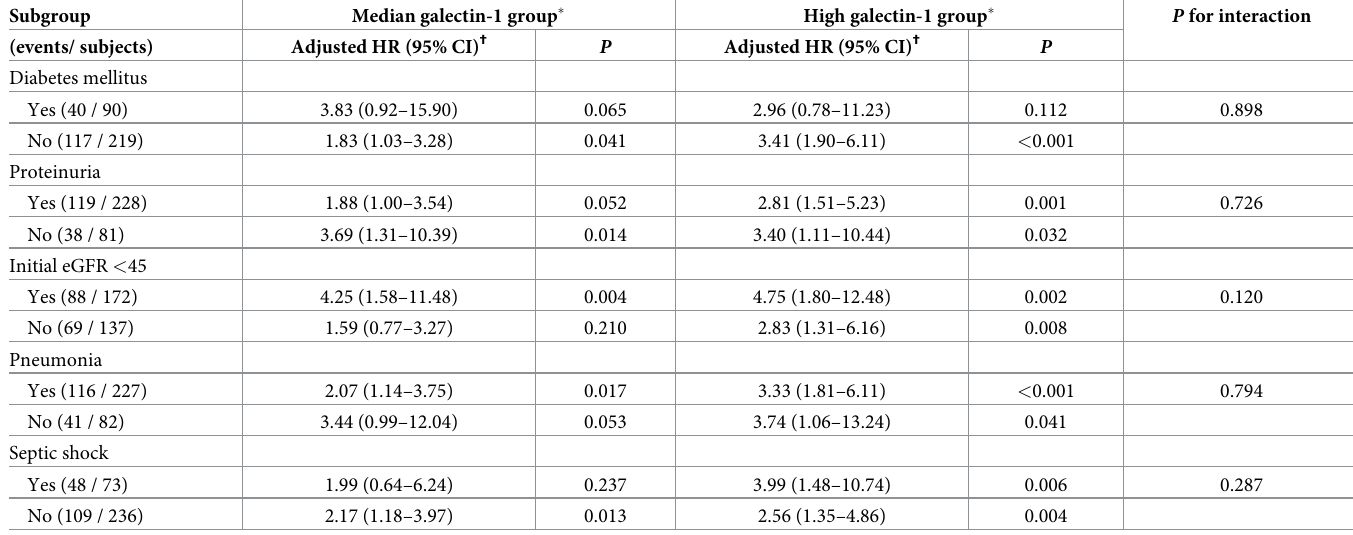
Table 4. Stratified risk of 90-day mortality among patients grouped by the presence of diabetes, proteinuria, renal insufficiency, pneumonia, and septic